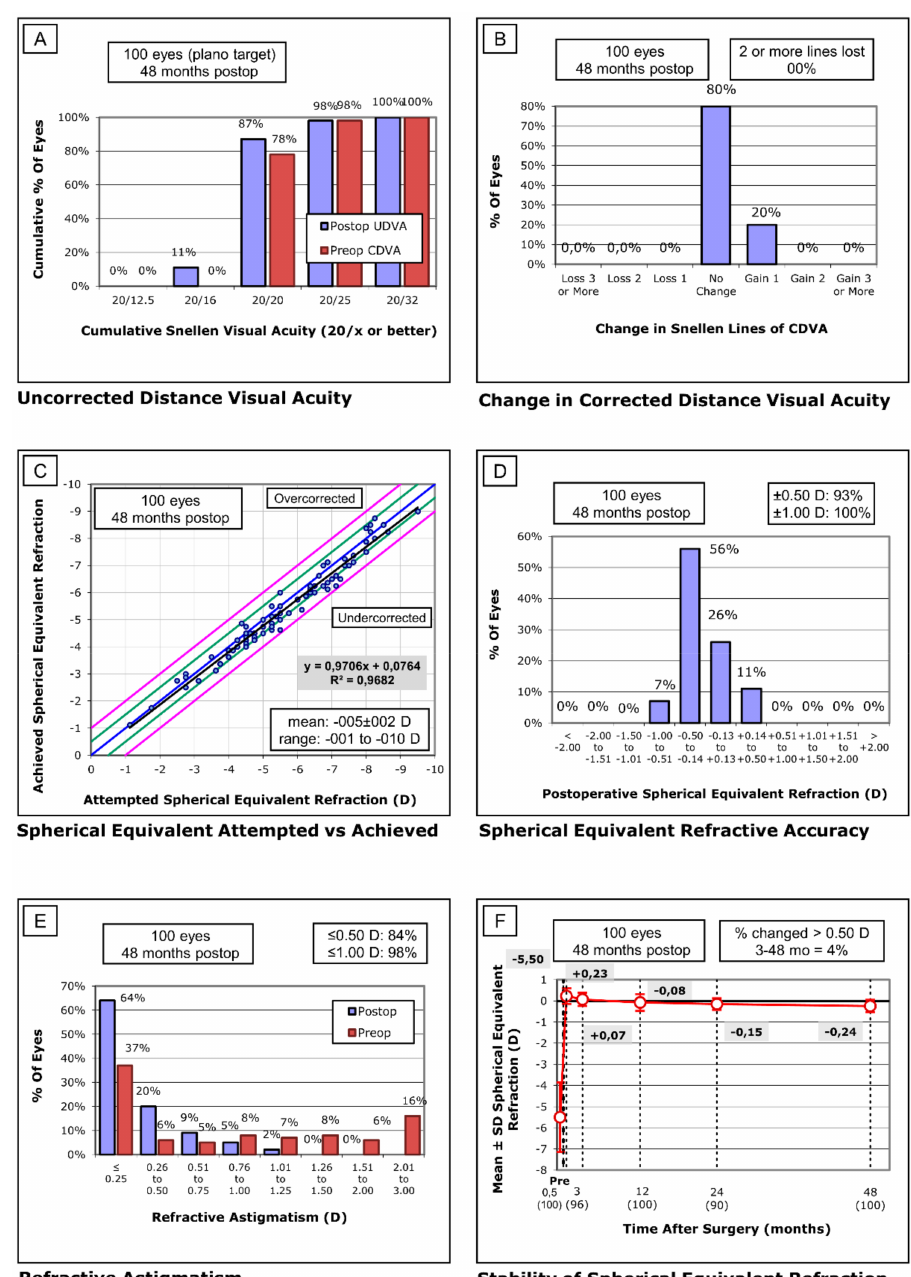
Figure 1. Femtosecond laser-assisted in situ keratomileusis (LASIK) with simultaneous prophylactic corneal cross-linking (CXL) standard graphs for reporting refractive surgery. ( A ) Uncorrected distance visual acuity (UDVA)—efficacy histogram. ( B ) Change in corrected distance visual acuity (CDVA)— safety histogram. ( C ) Spherical equivalent attempted versus achieved. ( D ) Spherical equivalent refractive accuracy. ( E ) Refractive astigmatism. Graphs ( C – E ) represent predictability. ( F ) Stability of spherical equivalent